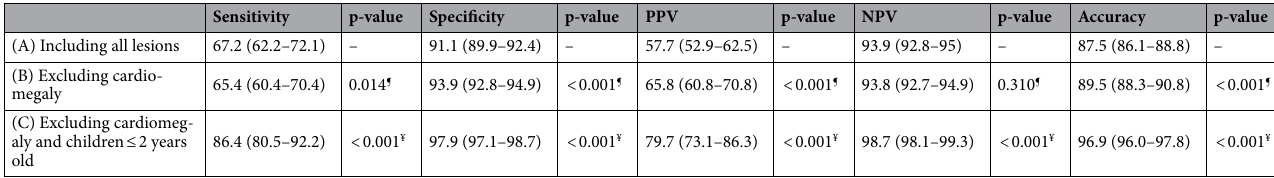
Table 1. Comparison of diagnostic performances of the AI-based software for subsets (A)–(C). Values are presented in percentages (%) with 95% confidence intervals. ¶ Comparison between subset (A) and (B). ¥ Comparison between subset (B) and (C). CI confidence interval, PPV positive predictive value, NPV negative predictive value.